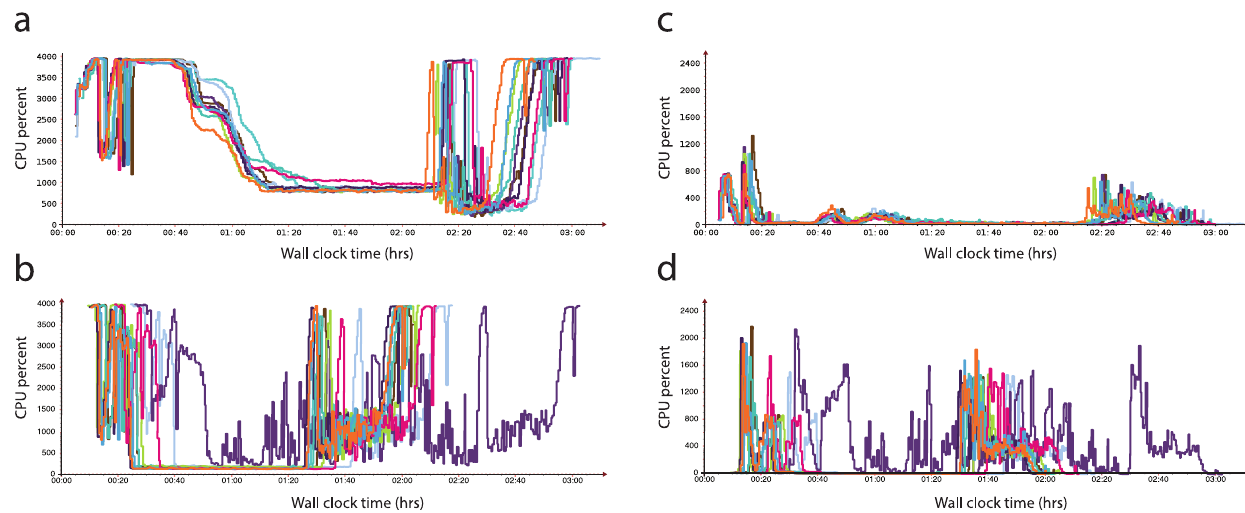
Figure 1. Comparison of undedicated cloud computing performances. The panel includes results of Amazon Web Services Elastic MapReduce (EMR) on Amazon EC2 instances (panels a & c) versus Google Compute Engine (GCE) (panels b & d) for human genome alignment and variant calling. In this 40 node cluster the total CPU percent for CPU idle (a and b) and waiting for disk input/output (c and d) is displayed. Note the greater consistency in performance of Crossbow, though generally longer wall clock times for complete analysis, on EMR compared to GCE.